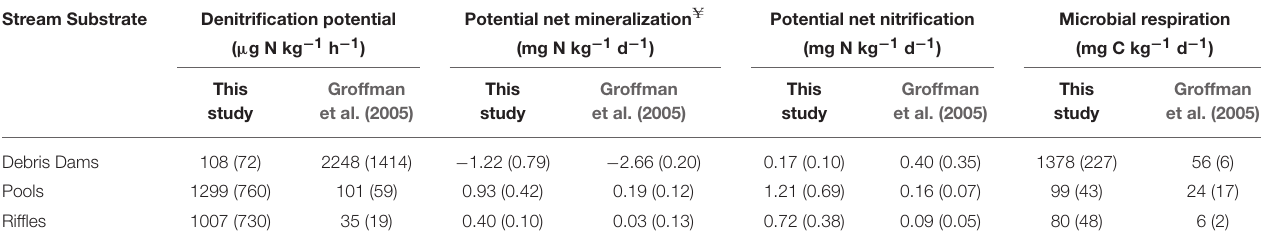
TABLE 4 | Mean rates (SE) from incubations of different stream substrates ( n = 6 for intermittent streams; n = 3 for Groffman et al., 2005). Stream Substrate